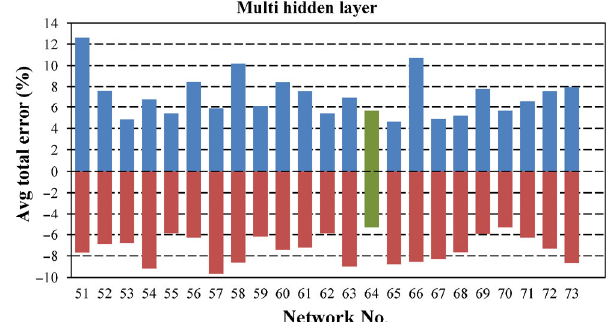
Fig. 17 Average total error% for multi hidden layer ANN architectures (Network Nos. 51 − 73). transfer function, and 9, 13, 9 neurons in each hidden layer, respectively. The total error% for optimized network (Network No. 64) was found to be ±4.5% for the amount of wear, ±0.5% for temperature, and ±3% Wear